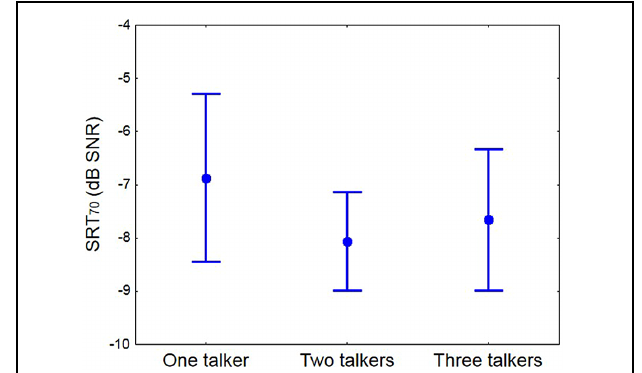
FIGURE 3 | The mean SRT 70 for each talker condition. Whiskers show 95% confidence interval.